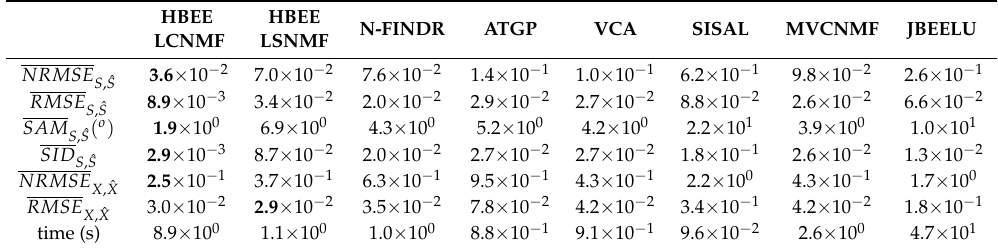
Table 4. Mean performance of each unmixing method applied to the synthetic data set. The mean performance values of HBEE-LSNMF have been calculated over the 6 endmembers estimated by the method.